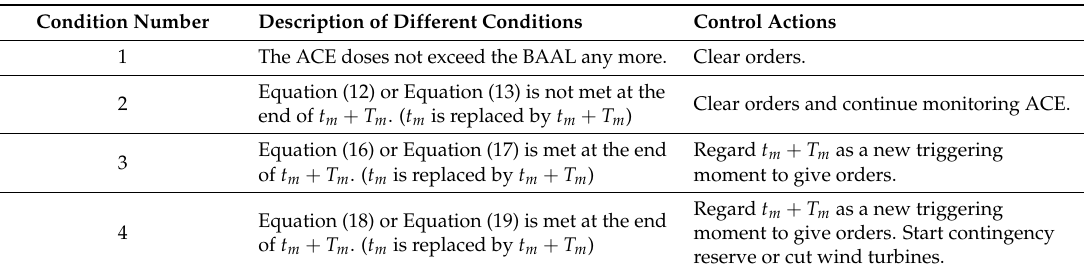
Table 2. Control actions under different